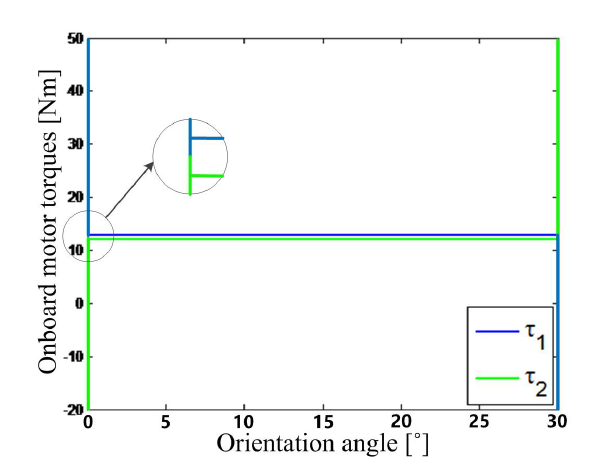
Figure 13. Required motor torques of the DWMR on the circular arc.